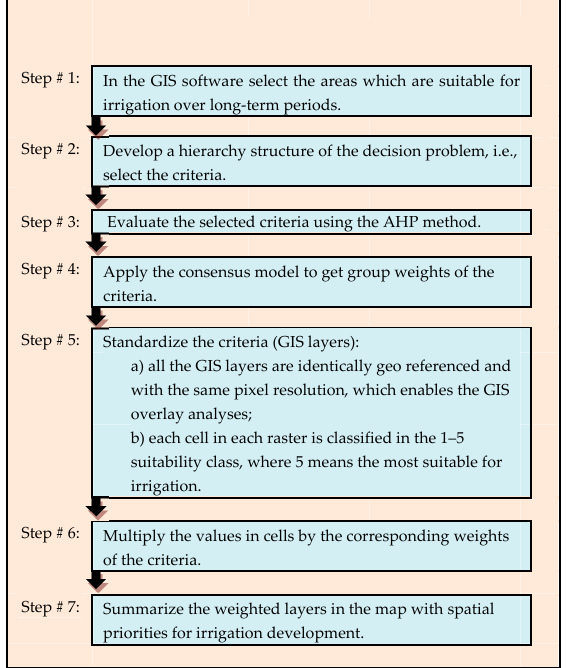
Figure 2. The methodology for defining spatial priorities for irrigation development.